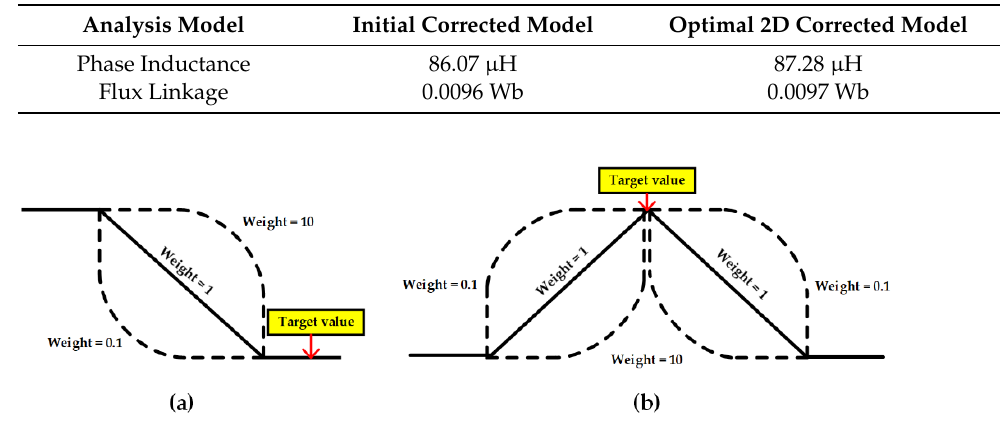
Table 3. Inductance and flux linkage of each analysis model.